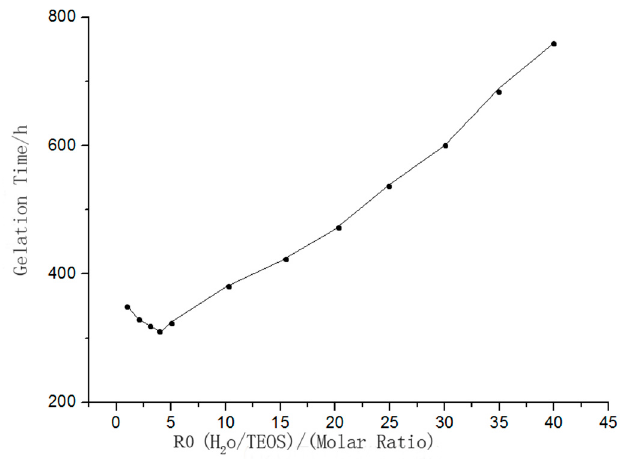
Figure 2. Relationship between water–silica ratio and system gelation time.